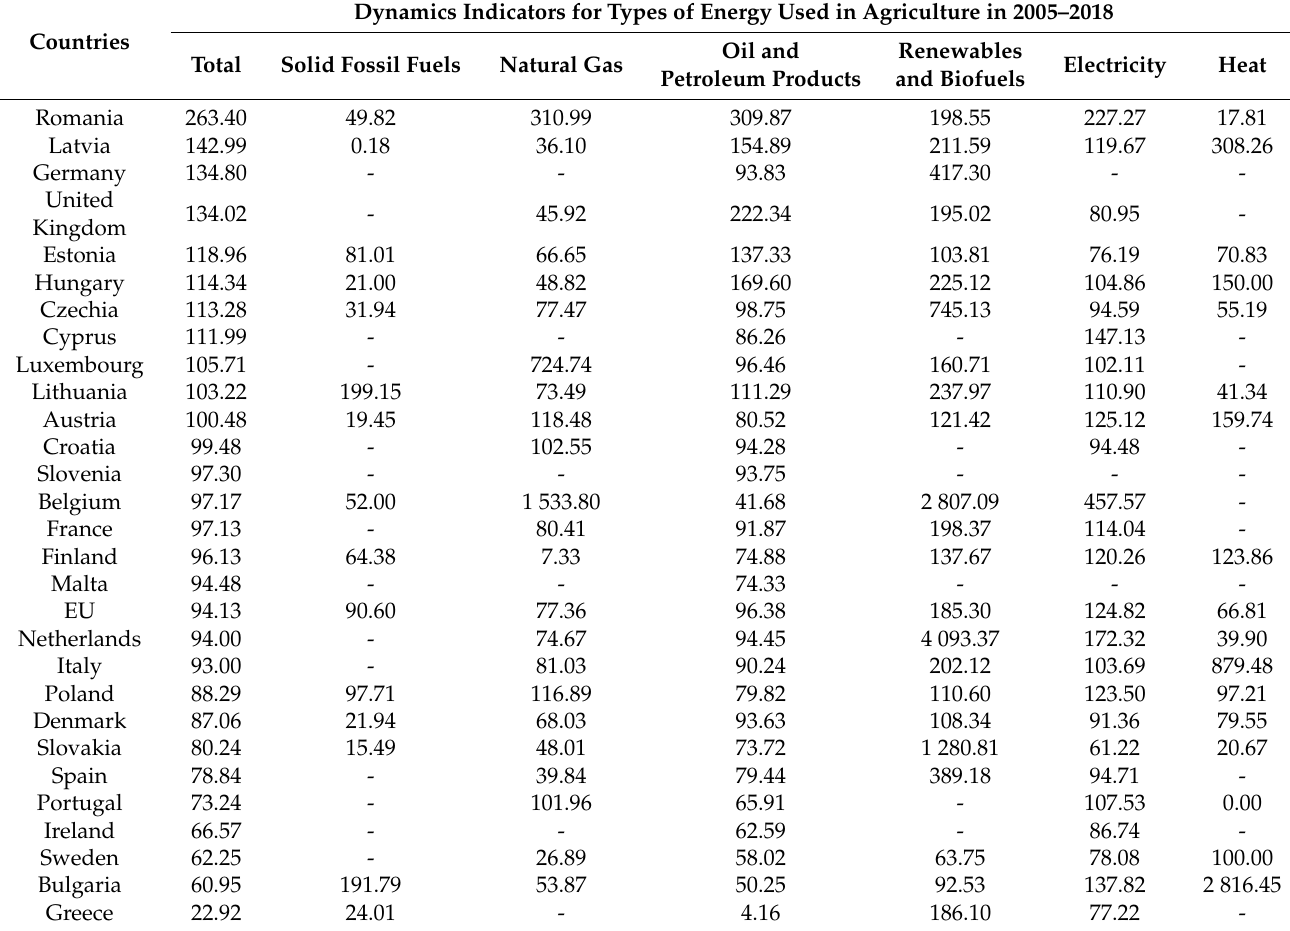
Table 2. Dynamics indicators for energy used in agriculture in EU countries in 2005–2018 (year 2005 = 100). Dynamics Indicators for Types of Energy Used in Agriculture in Countries